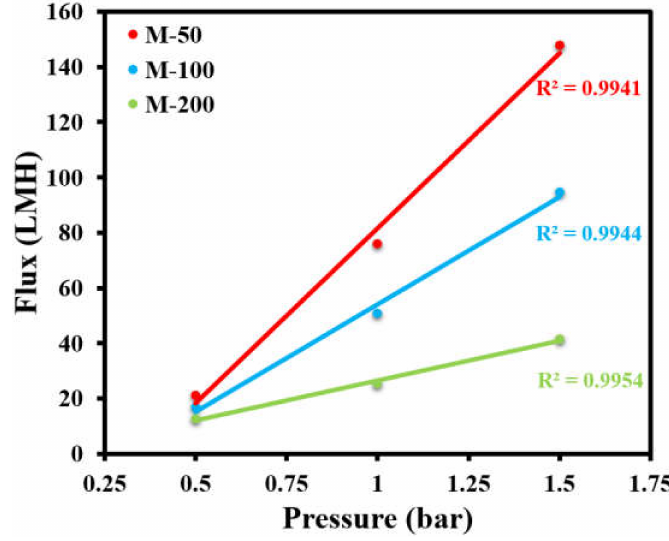
Figure 8. Effect of applied transmembrane pressure on permeate flux of all membranes.